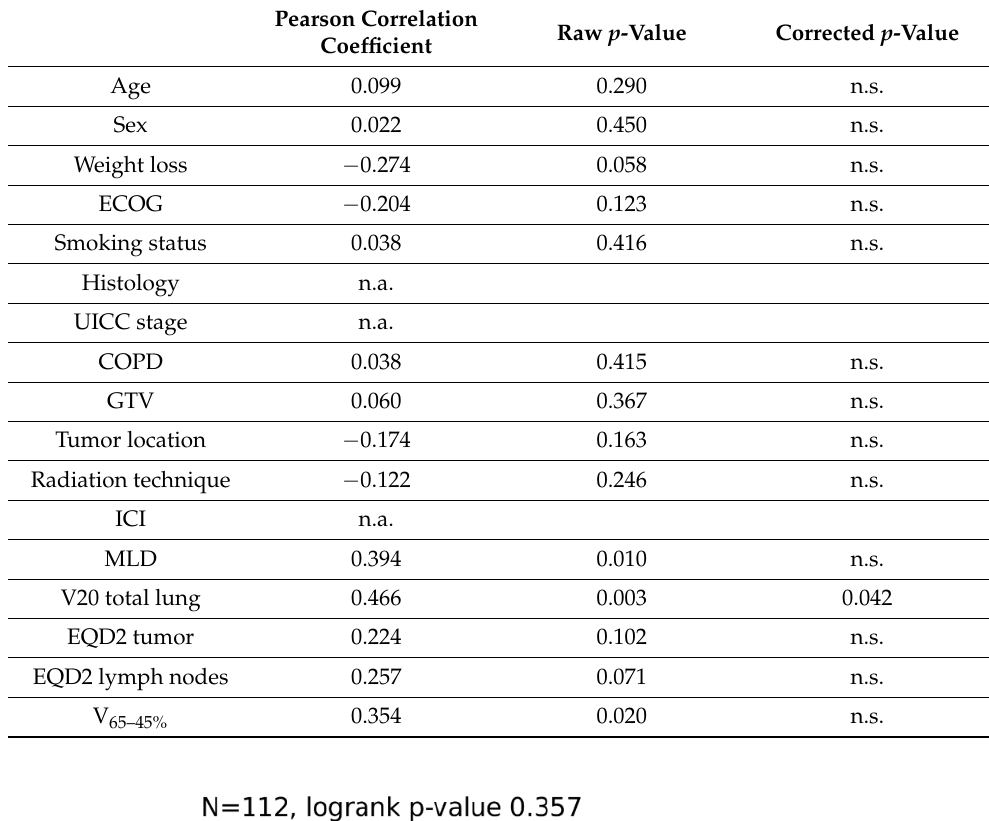
Table A3. Correlation of DL CO decline > 10% with clinical and treatment-related parameters (GTV = gross tumor volume, ICI = immune checkpoint inhibitor, MLD = mean lung dose, V 20 Total Lung = lung volume receiving 20 Gy or more, EQD2 = biologically equivalent dose in 2 Gy fractions), V 65–45% (lung volume receiving between 45% and 65% of the prescribed dose). Bonferroni correction was performed to account for multiple testing.